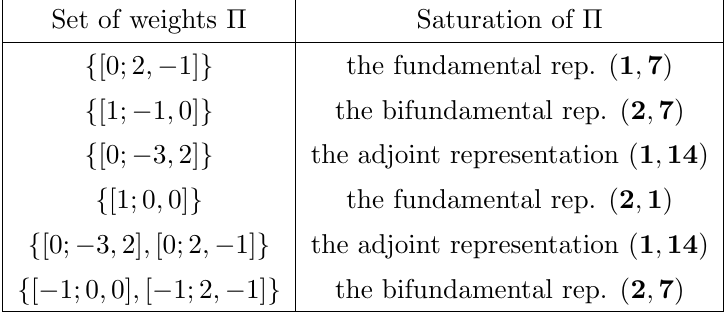
Table 9 . Representations derived from saturation of